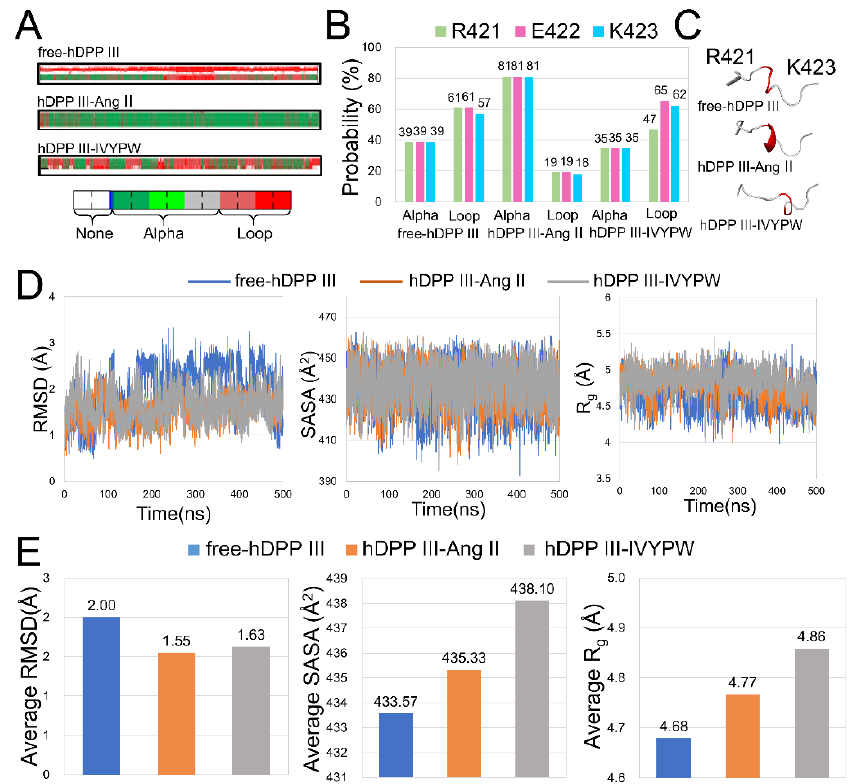
Figure 10. ( A ) DSSP analysis of Arg421-Lys423 residues in three systems throughout 500 ns simula- tions. ( B ) Probabilities of α -helix and loop for Arg421-Lys423 residues. ( C ) Structures of Arg421- Lys423 residues (red) in cartoon form. ( D ) RMSD, R g , and SASA plots for Arg421-Lys423 residues in three systems. ( E ) Average RMSD, R g , SASA values for Arg421-Lys423 residues in three systems.